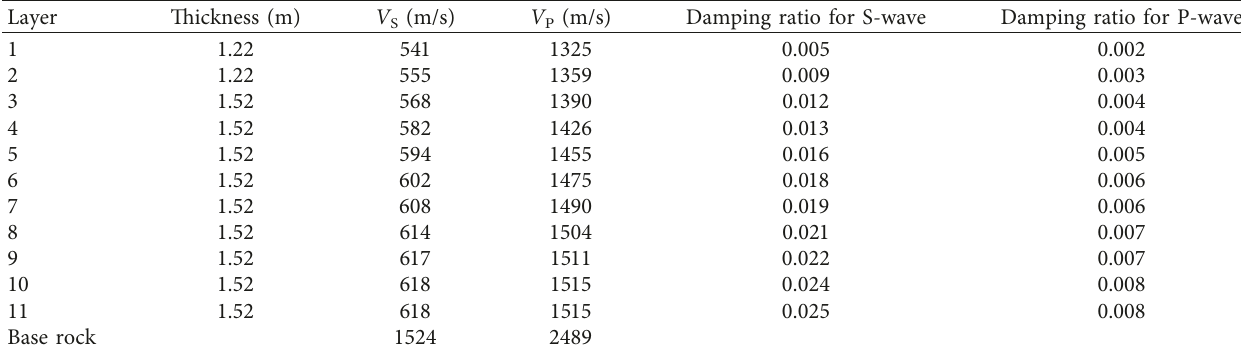
Table 1: Soil layers and properties of the condition A1.